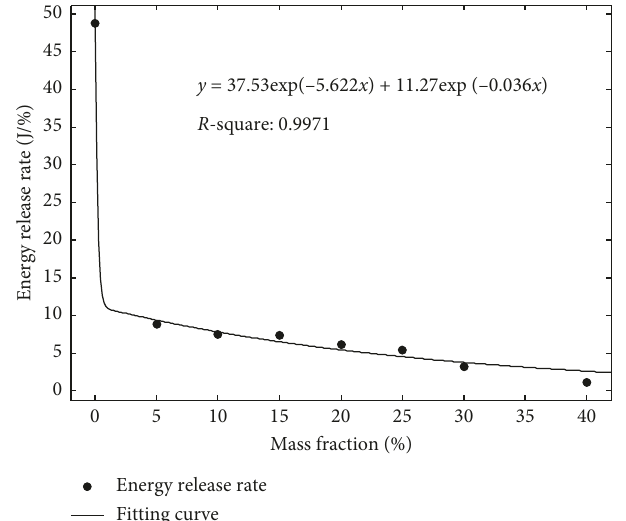
Figure 14: The relationship between energy release ratio of CRC and rubber content.